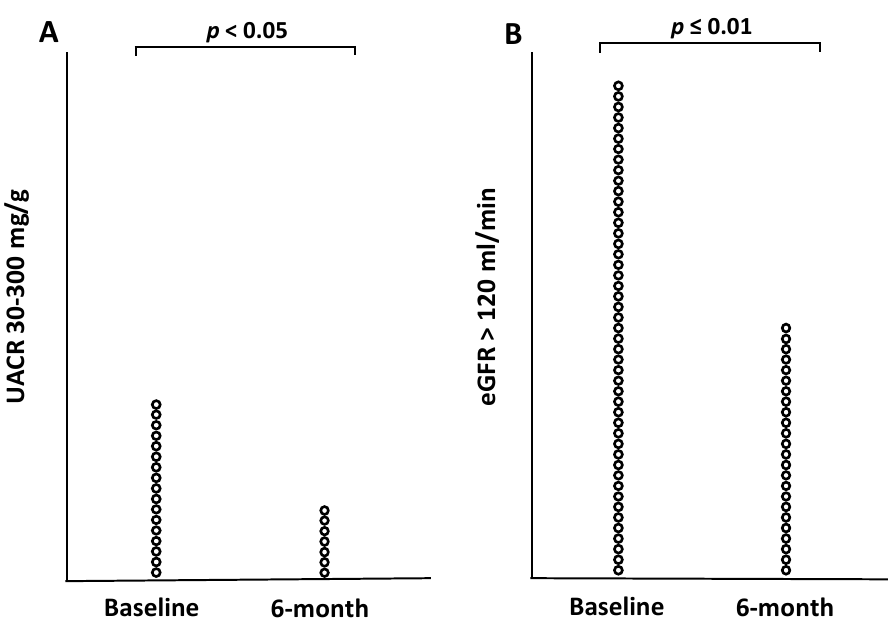
Figure 2. ( A ): Number or patients with increased albuminuria at baseline and 6 months. ( B ): Number of patients with hyperfiltration at baseline and 6 months.